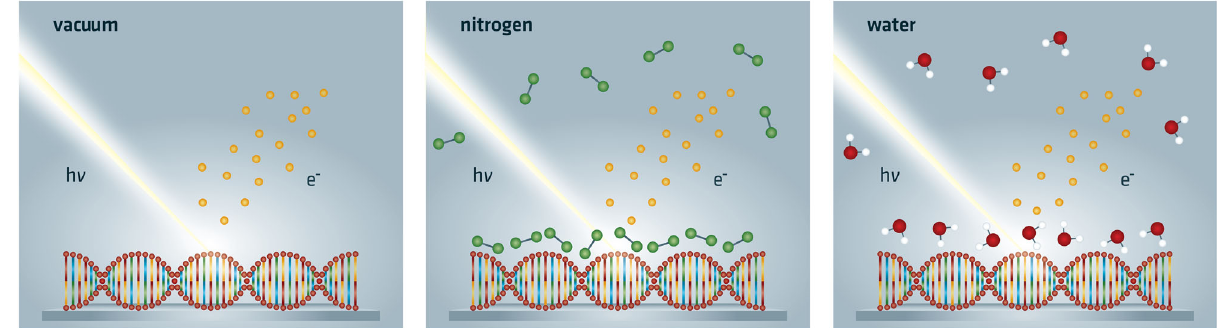
Fig. 1 Sketch of the three irradiation conditions applied. X-rays pass through the vacuum, nitrogen, or water atmosphere, scatter at the DNA, and eject